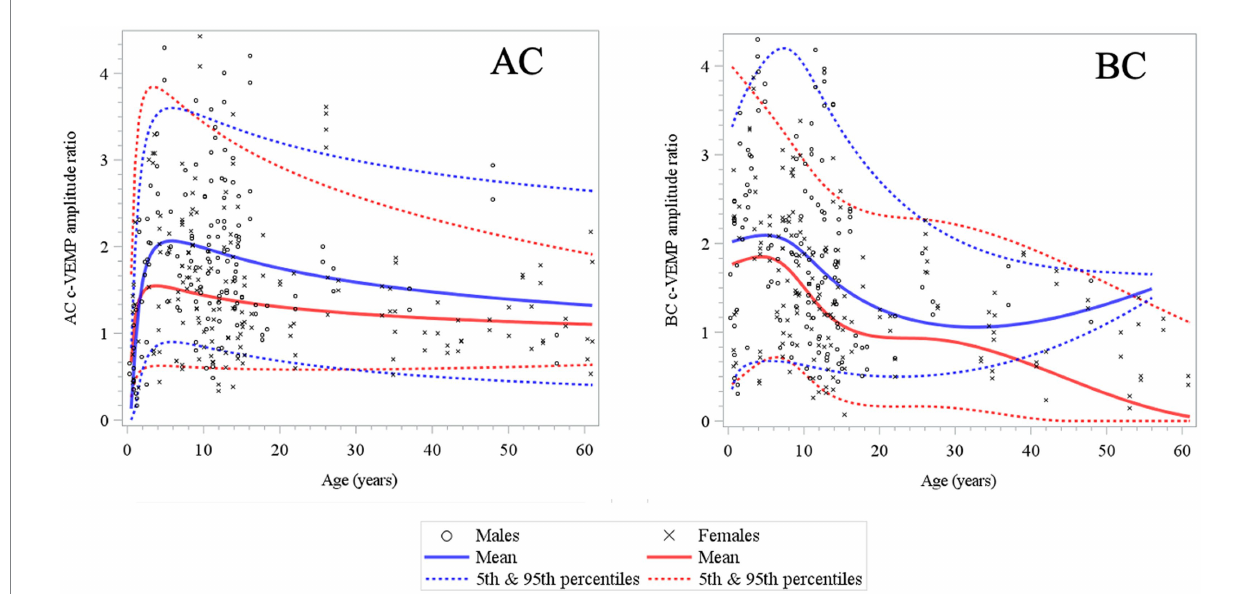
FIGURE 6 Changes in c-VEMP amplitude ratio for AC (air conduction) and BC (bone conduction) stimulation mode as a function of age and gender (6 months to 61 years) (26). Note that rapid changes occur mostly during early childhood (4–5 years) for AC and BC and there is after a slow and gradual decrease in all other age intervals. The tendency for an increase in older males of the mean curve in BC may be explained by the size and the asymmetric sex ratio distribution (11 males and 30 females) of the adult population.